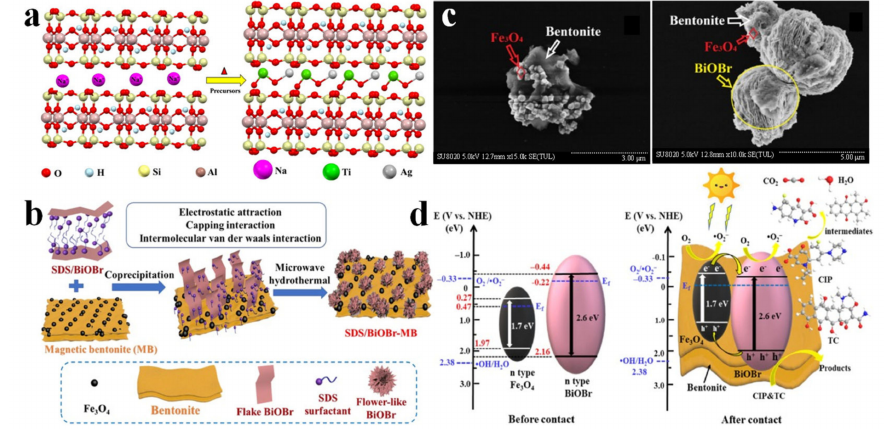
Figure 6. ( a ) Schematic illustration of the reaction mechanism of Ag/TiO 2 nanoparticles and its intercalation processes into the bentonite clay; ( b ) scheme of SDS/BiOBr − MB synthesis; ( c ) FE − SEM images of magnetic bentonite (MB) and BiOBr − MB at 15 k and 10 k magnification; ( d ) schematic representation of the mechanism of enhanced photodegradation of tetracycline (TC) and ciprofloxacin (CIP) by SDS/BiOBr − MB. Adapted with permission from Ref. [10]. Copyright 2020, Elsevier B.V; Adapted with permission from Ref. [137]. Copyright 2017, Elsevier